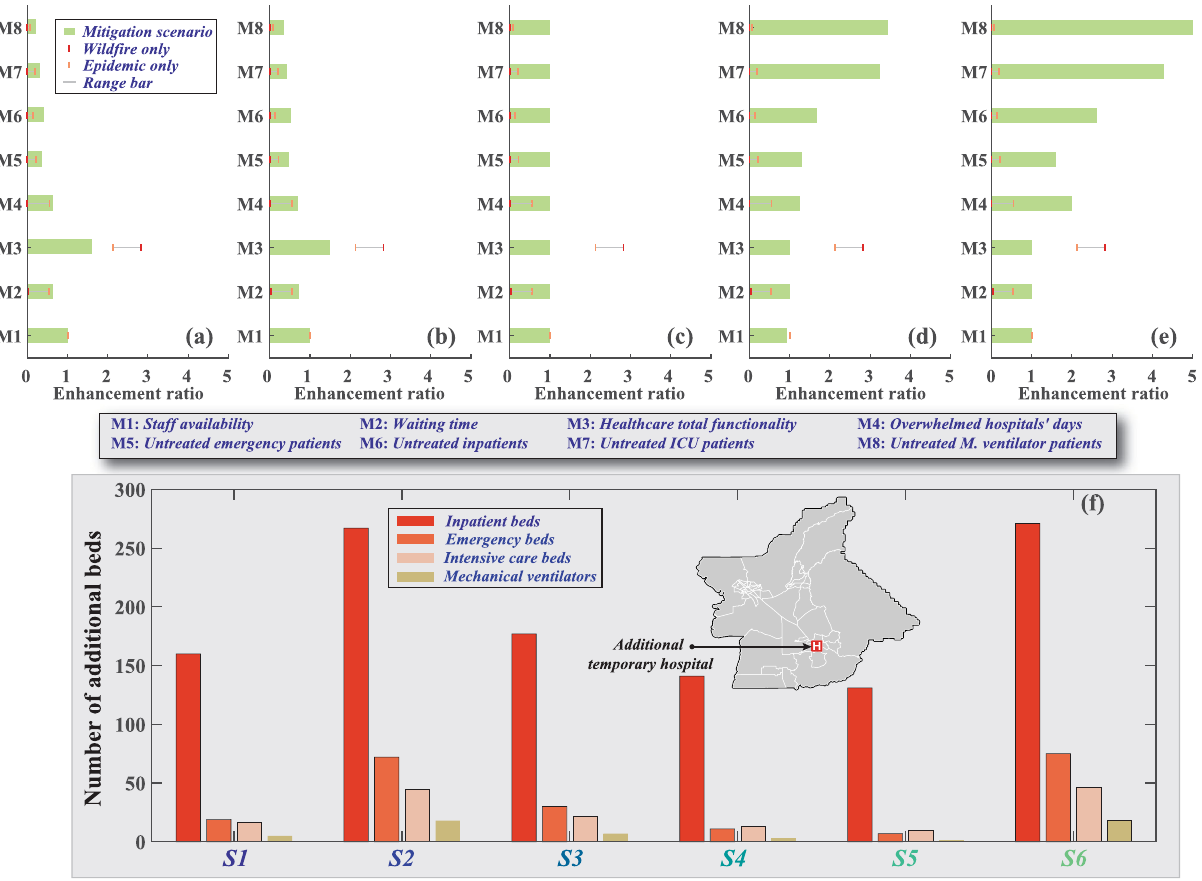
Fig. 4 The effect of different mitigation strategies on healthcare system performance indicators. These indicators including staff availability, waiting time, total functionality, and the total number of hospitals overwhelmed days and the patients ’ accessibility to medical services comprising ER, inpatient admission, ICU, and mechanical ventilators. The indicators are normalized by the reference case that used the US (S6) disease spread rates and assumed that the wild fi re would occur 40 days after the disease outbreak. These normalized indicators are also compared with the normalized wild fi re only and pandemic only scenarios and plotted as a range bar. These mitigation strategies are a applying stronger measures during the evacuation process, b provide more protections for the shelter residents, and c provide more protection for the frontline medical staff. We also show the effectiveness of other mitigation strategies we implemented in the analysis, including d replacing staff and e using non-acute care beds for non-critical inpatient cases. f We also present the optimization results for the location and number of different staffed beds needed for each of the considered disease spread